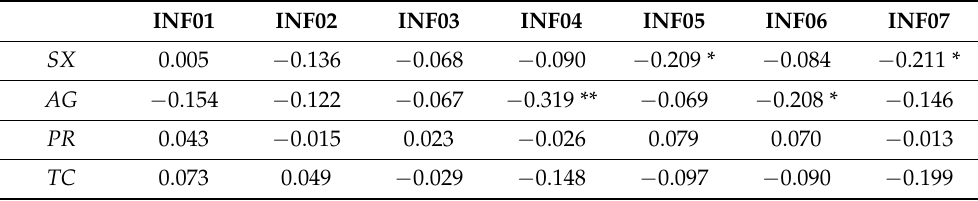
Table A8. Spearman correlation matrix: use of information access and management